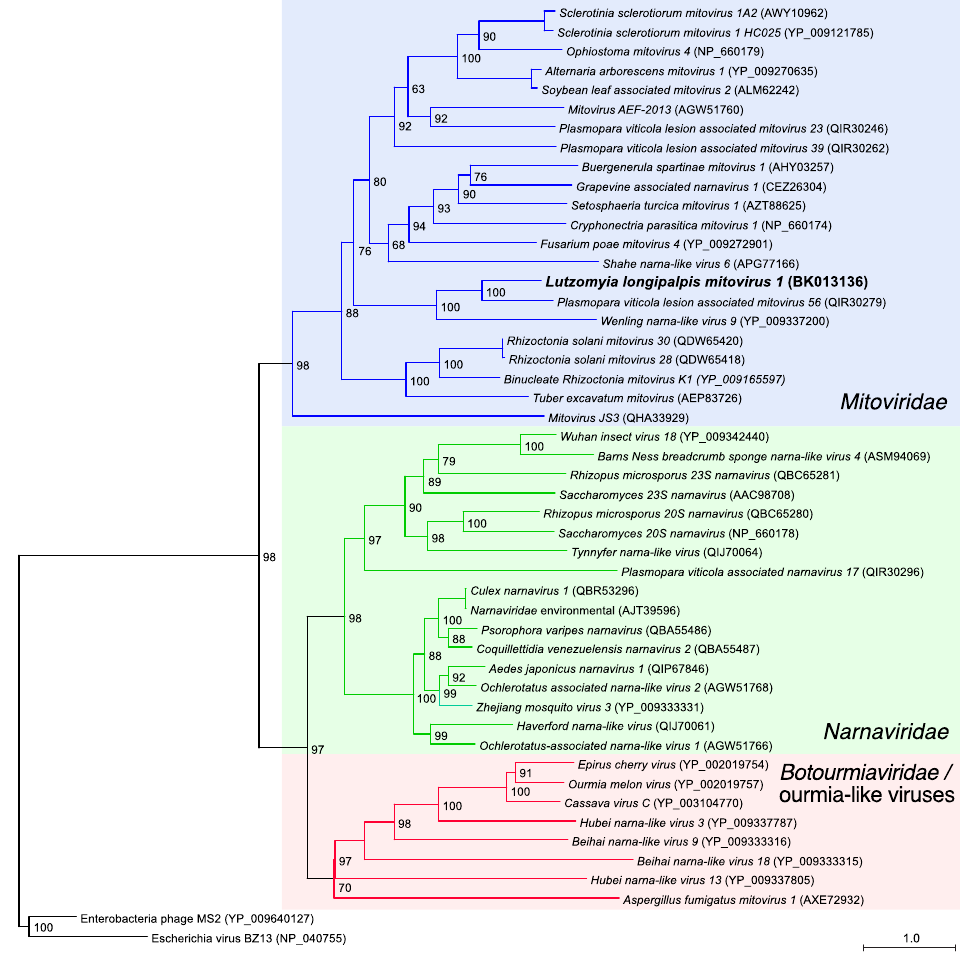
Figure 2. Phylogenetic analysis. Phylogenetic tree inferred by maximum likelihood using full-length amino acid sequences of the RNA-dependent RNA polymerase (RdRp). Phylogenetic reconstruction was performed with IQ-TREE using the evolutionary model Blosum62 + F + R6 and 1000 bootstrap pseudoreplicates. The tree was rooted using two sequences of ssRNA bacteriophages belonging to Leviviridae family. Colored clades correspond to the familis Mitoviridae (blue) and Narnaviridae (green), and to Botourmiaviridae/ ourmia - like viruses (red).